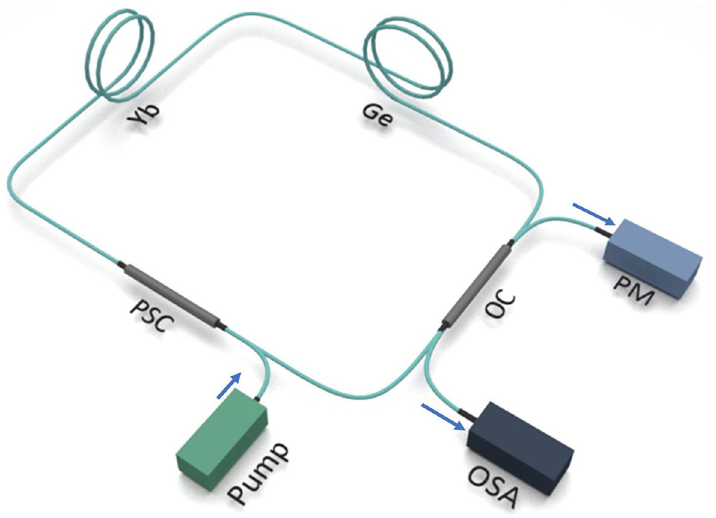
Figure 1. General scheme of the all-fiber ring laser. The setup consists of a pump diode (pump), pump signal combiner (PSC), an active Yb-doped fiber (Yb), a passive Ge-doped fiber (Ge), and an output coupler (OC). The output signal is monitored by an optical spectrum analyzer (OSA) and a power meter